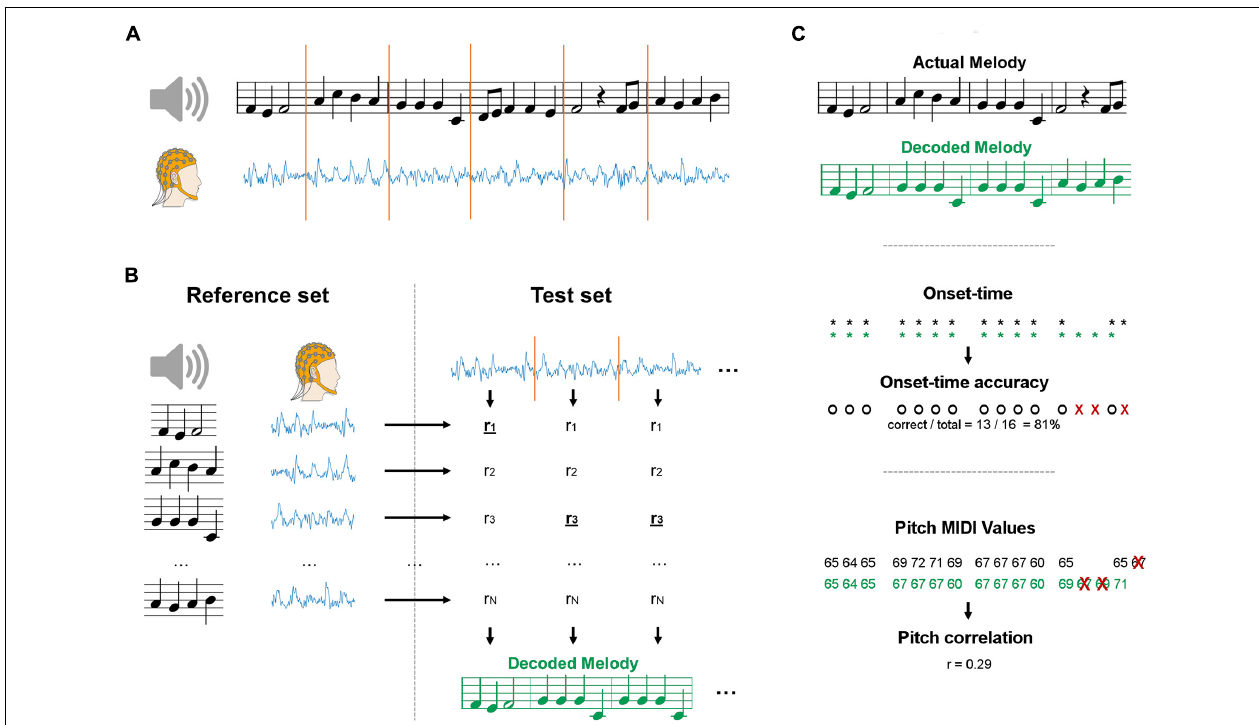
FIGURE 1 | Schematics of the maxCorr decoding approach. (A) EEG data was recorded as participants either imagined or listened to monophonic music. Signals were segmented into a reference and test datasets. (B) EEG data from each segment was compared with the EEG segments in the reference set with cross-validation. The melody corresponding to the EEG segment with highest similarity was selected. The procedure was repeated for various segment sizes, always multiples of the size of a music bar. (C) The quality of the melody decoding was assessed by means of two distinct metrics. The first evaluation metric measured the accuracy in detecting the onset-time of the notes (black: actual melody; green: decoded melody). The second evaluation metric measured the correlation of the pitch values between decoded and actual melodies. The correlation was evaluated on the notes whose temporal onset was correctly identified (all other notes were